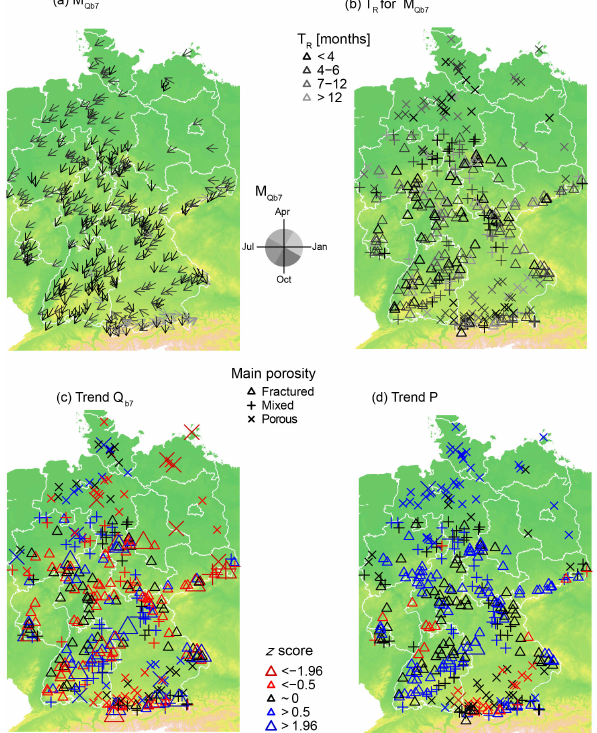
Figure 4. Patterns of Q b7 across Germany. (a) Low-flow month M Q and (b) seasonal response time T R . (c) Trend of Q b7 and b7 (d) P in the relevant recharge period for